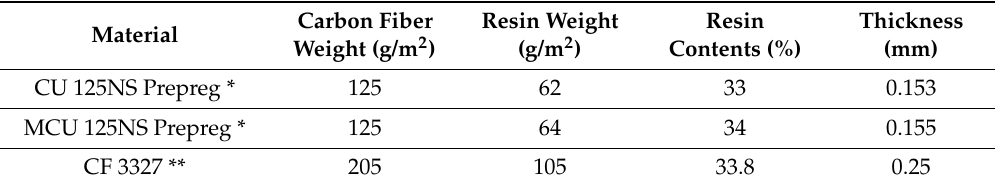
Table 1. Specifications of applied fiber.